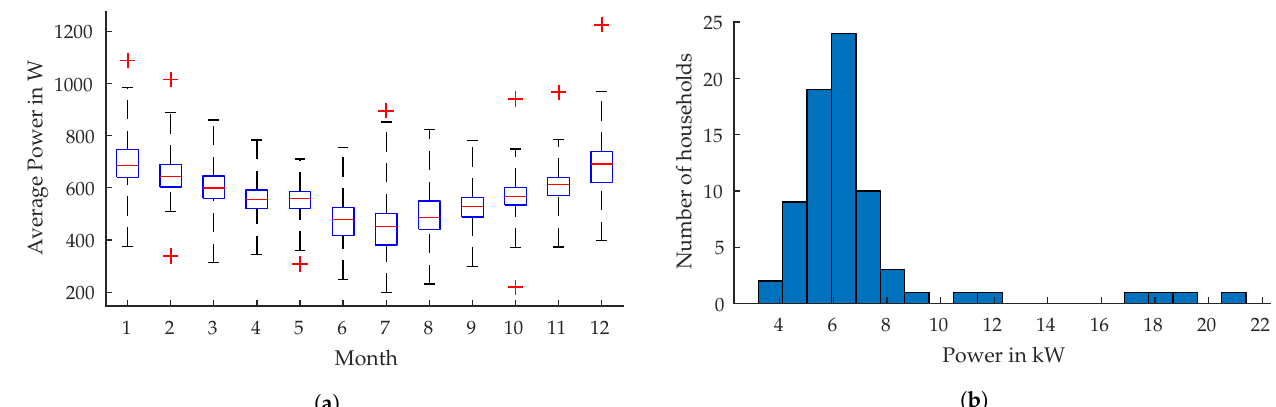
Figure 7. ( a ) Monthly averages in power consumption. ( b ) Maximum power by household (15 min average). In Figure 8, statistics for daily load averages, depicted as a load duration curve, are shown. There is one clear extreme outlier (household 25) at high loads, which are those critical for the sizing of the battery storage. This household was excluded.